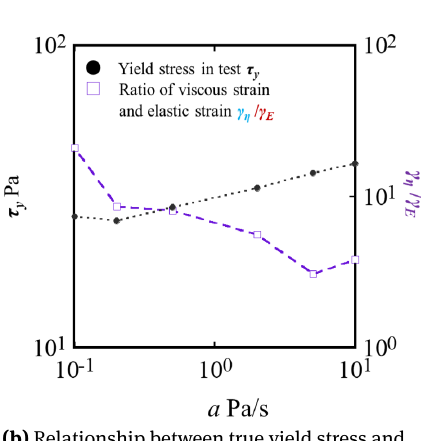
Figure 15: Strain contribution of viscosity and elasticity to the true yield characteristic in the stress-ramp test. (a) The viscoelastic contribution in the true yield strain and (b) the relationship between the true yield stress and the ratio of the viscous and elastic strains